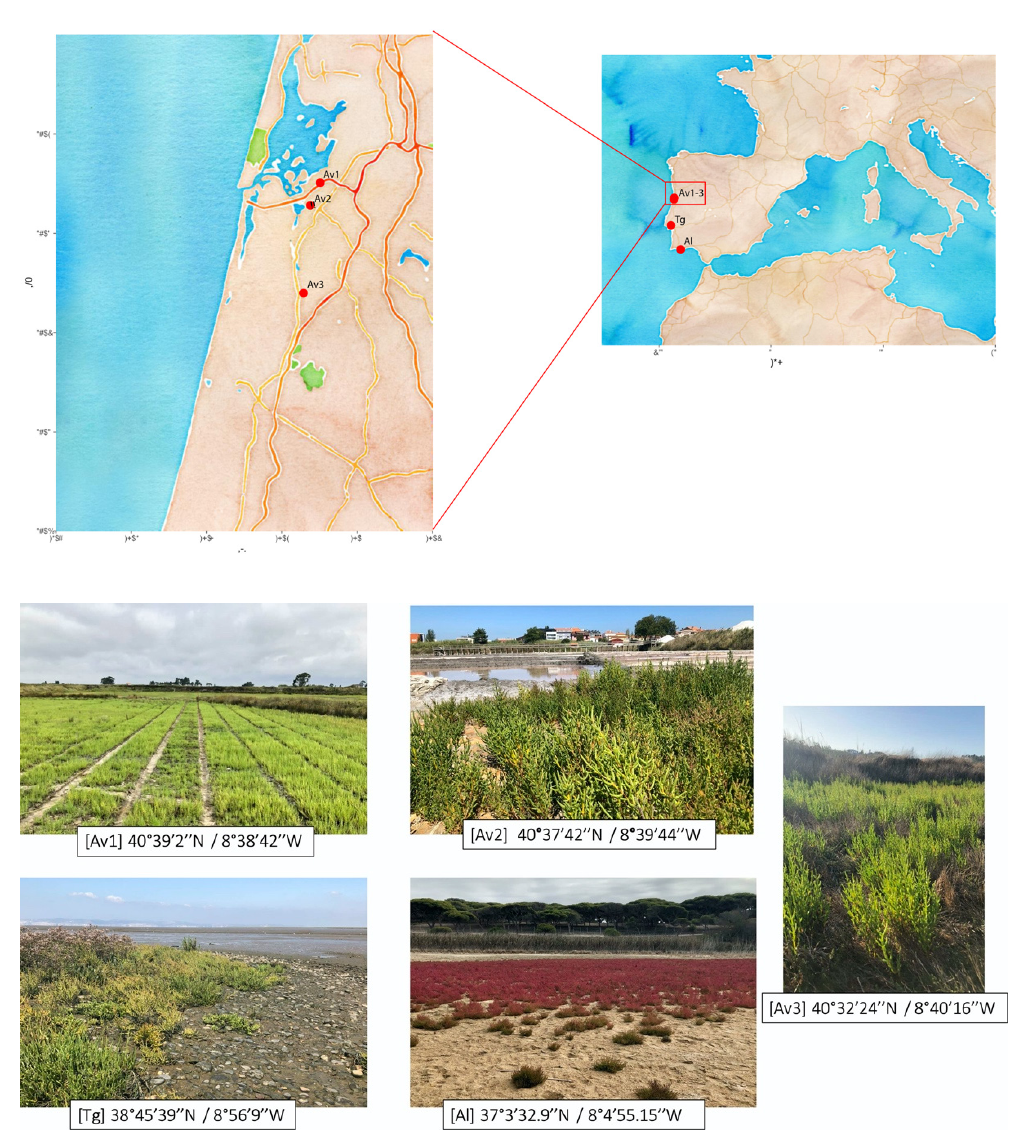
Figure A1. Sampling sites located along the Portugal coast. Locations Av1, Av2, Av3 correspond to three different sites at Ria de Aveiro; Tg and Al correspond to the Tagus estuary and Almargem coast, respectively.